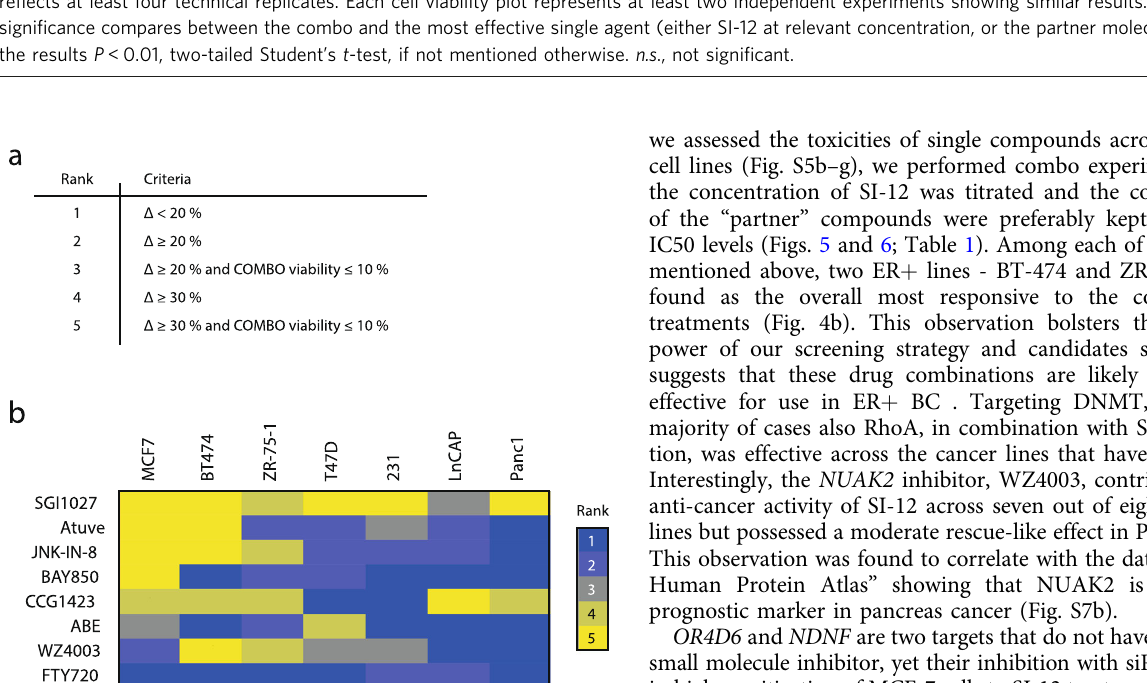
effect in combination with SI-12 across seven out of eight tested cell lines with maximal gap of 30% between the killing effects of a single drug and the combo (Fig. 4b).